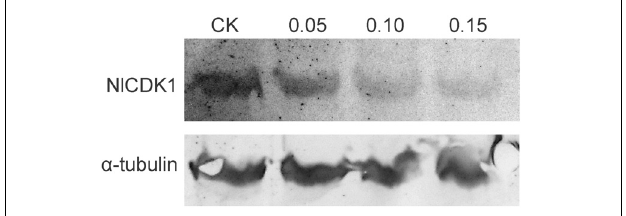
FIGURE 10 | Western blot detects the phosphorylation at Thr-14 of NlCDK1 kinase.